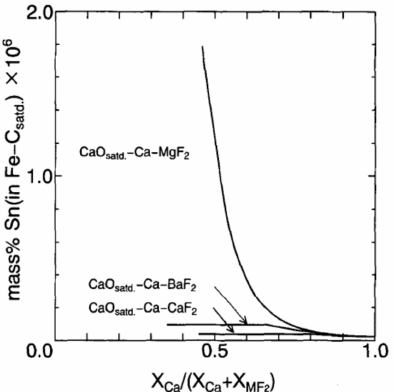
Figure 4. Balanced concentration of Sn in the carbon-saturated iron solution treated with calcium metal fluoride solvent [63].